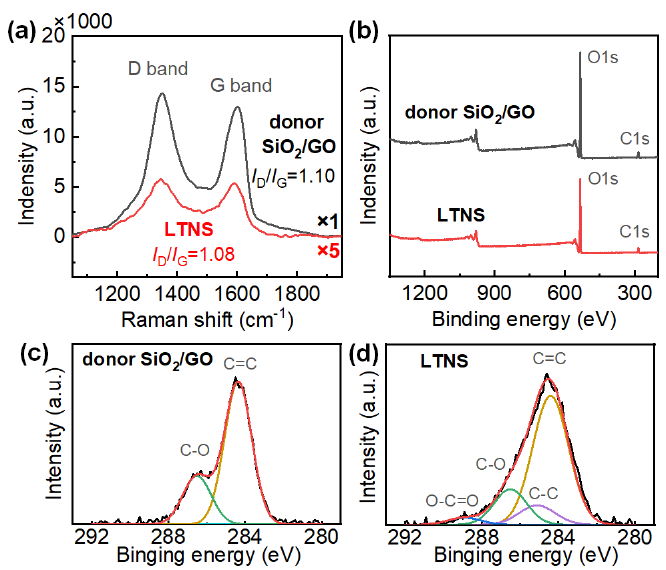
Figure 7. ( a ) Raman spectra and ( b ) XPS spectra of the donor film and the LTNS film. The C1s peaks for ( c ) the donor film, and ( d ) the LTNS film.